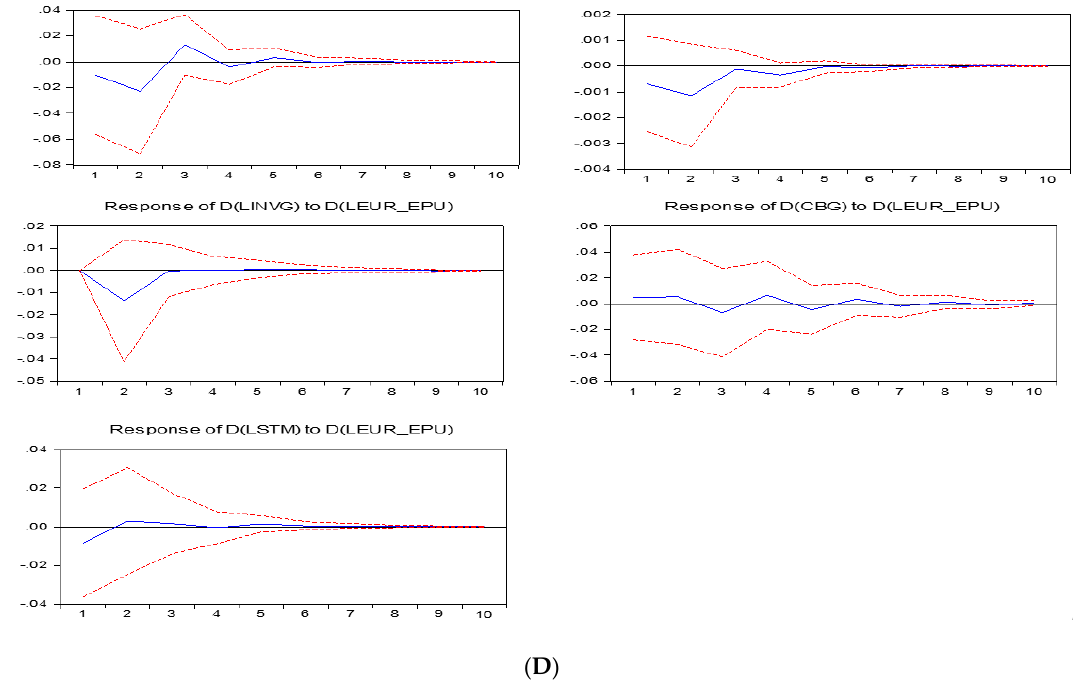
Figure 1. Shows the impulse response function of consumption, inflation, investment, credit growth and stock market to domestic EPU and foreign EPUs of USA, UK and Europe in context of Brazil. ( A ) Impact of Domestic EPU on Brazil. Note: It shows the impulse response function of consumption, inflation, investment, credit growth and stock market to a Cholesky one standard deviation domestic EPU in context of Brazil. Whereas, the two outer lines are Monte Carlo constructed 95% confidence interval; ( B ) Impact of US EPU on Brazil. Note: It shows the impulse response function of consumption, inflation, investment, credit growth and stock market to a Cholesky one standard deviation foreign EPU i.e., USA in context of Brazil. Whereas, the two outer lines are Monte Carlo constructed 95% confidence interval; ( C ) Impact of UK EPU on Brazil. Note: It shows the impulse response function of consumption, inflation, investment, credit growth and stock market to a Cholesky one standard deviation foreign EPU i.e., UK in context of Brazil. Whereas, the two outer lines are Monte Carlo constructed 95% confidence interval; ( D ) Impact of Europe EPU on Brazil. Note: It shows the impulse response function of consumption, inflation, investment, credit growth and stock market to a Cholesky one standard deviation foreign EPU i.e., Europe in context of Brazil. Whereas, the two outer lines are Monte Carlo constructed 95% confidence interval.